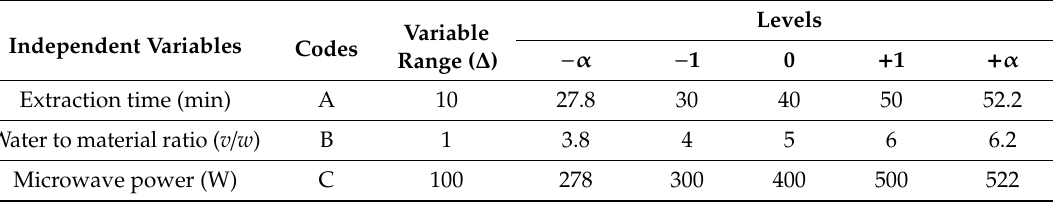
Table 1. Ranges of parameters determined by experimental design.